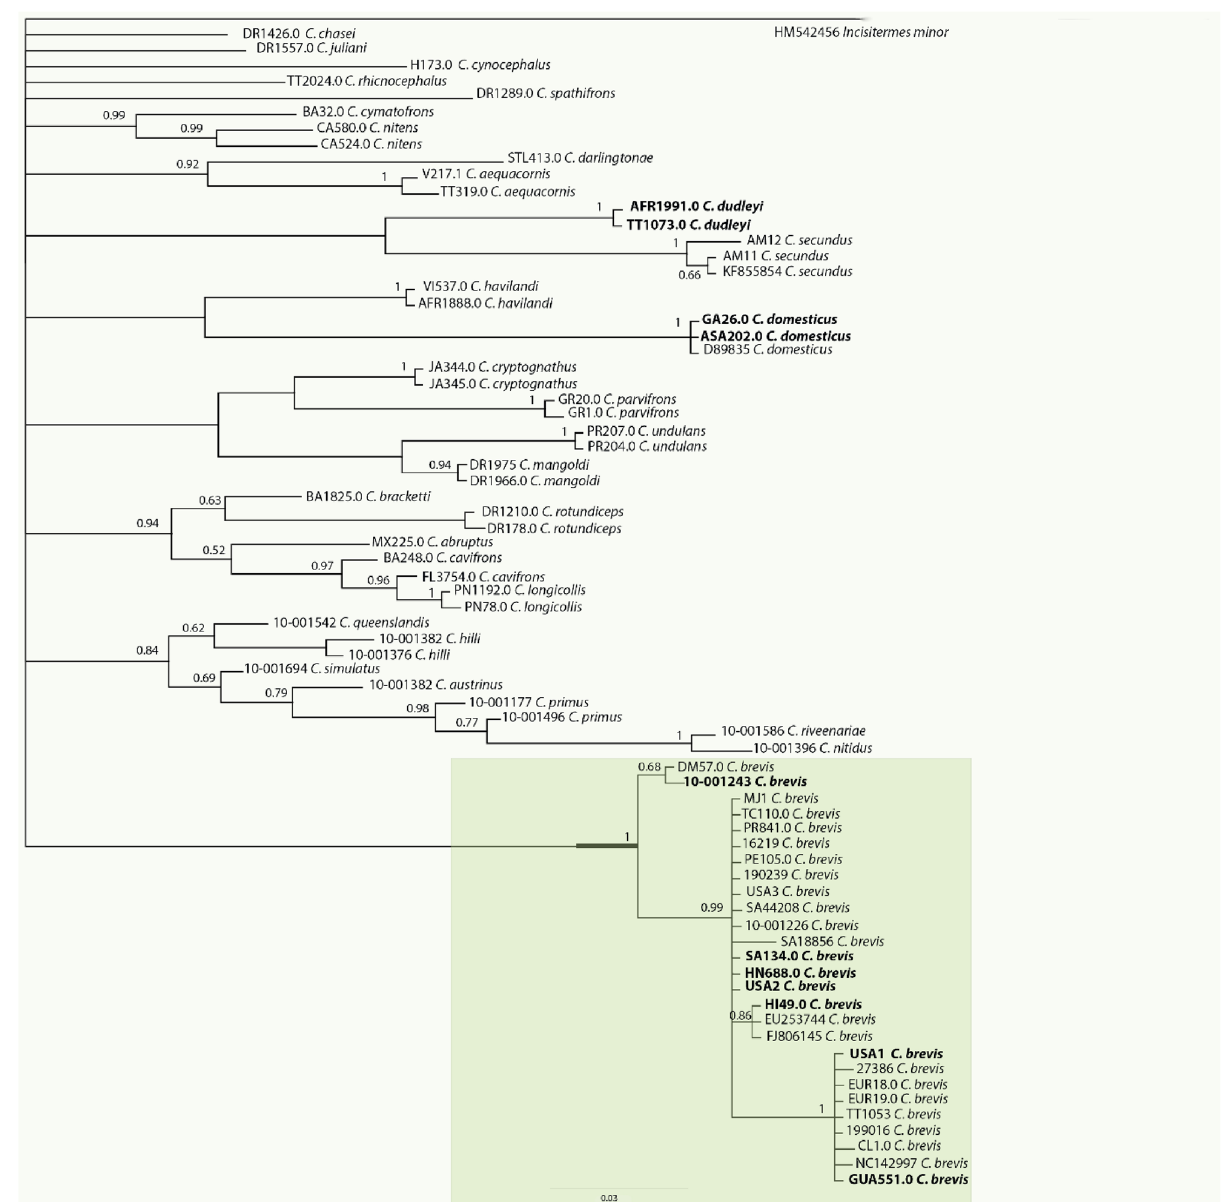
Figure 2. Bayesian phylogram of mt16S rRNA sequences showing the phylogenetic relationships of Cryptotermes species used in this study. Numbers represent Posterior probabilities for the nodes. Species tested in LAMP assay are in